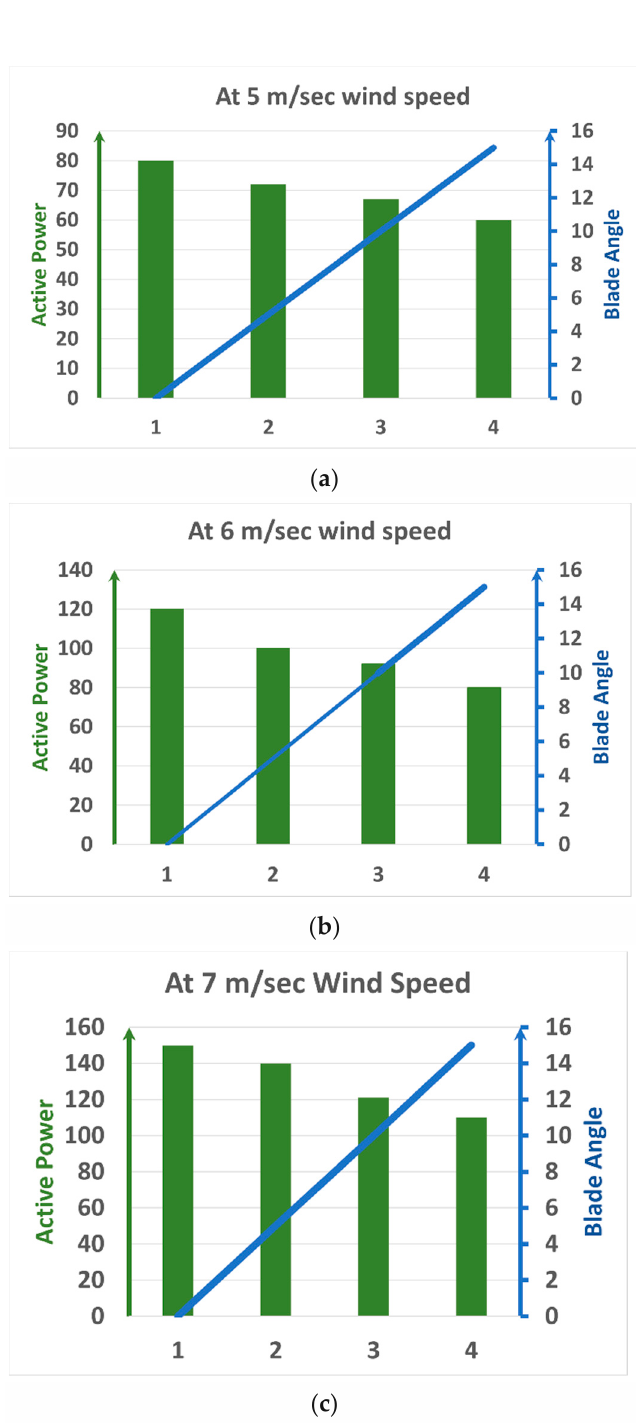
Figure 4. ( a ) Active power responses for different blade angles at 5 m/s wind speed. ( b ) Active power responses for different blade angles at 6 m/s wind speed. ( c ) Active power responses for different blade angles at 7 m/s wind speed.